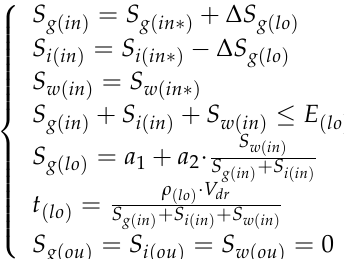
Figure 3. Decomposition of the grain dryer into functional units. 1. Loading unit; 2. drying chamber; 3. cooling unit; 4. unloading unit; 5. source of drying air.